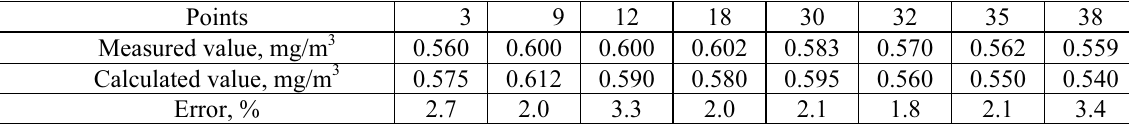
Table 2. Comparison of the results obtained experimentally (on April 26, 2005) and theoretically